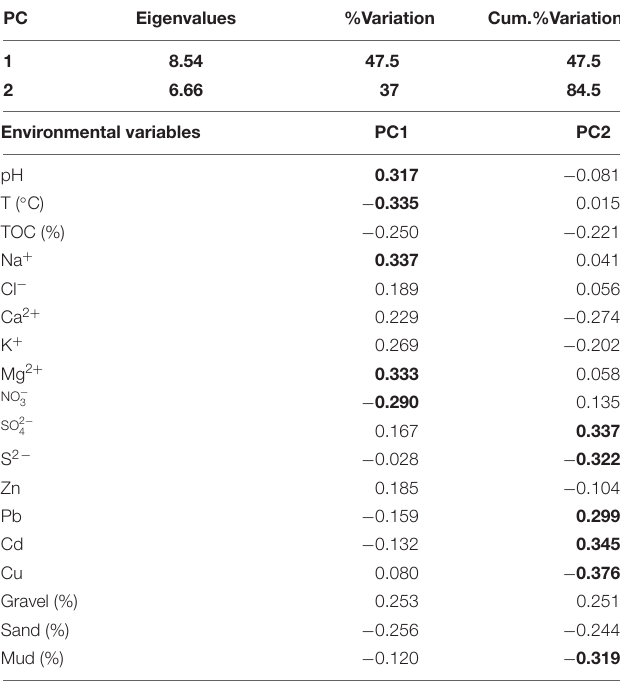
TABLE 2 | Principal component loadings for hydrothermal and control sites from PCA of environmental data from four sites sampled at the Secca delle Fumose hydrothermal zone.